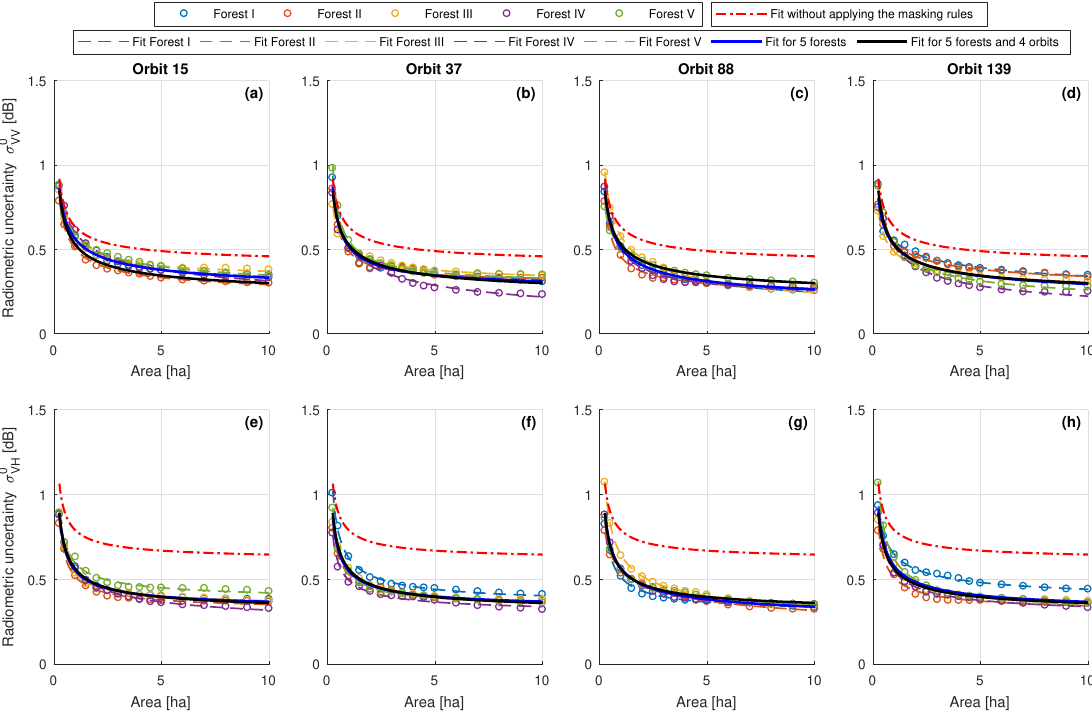
Figure 10. Radiometric uncertainty ( s S 1 ) of the Sentinel-1 VV observations ( a – d ) and the Sentinel-1 VH observations ( e – h ). The points are calculated s S 1 values and the lines are the fitted second-order power functions (Equation (3)). The s S 1 is calculated on the forest σ 0 timeseries after application of the developed masking rules. For comparison the red lines show the combined fits over the four orbits and the five forests of s S 1 without applying the masking rules. The model coefficients of the fits are listed in Tables 6 and 7. Table 6. Model coefficients of the second-order power function between A and s S 1 (Equation (3)) of the Sentinel-1 VV observations over the five forests combined. The E RMS is the root mean squared deviation between the function and the underlying data points.